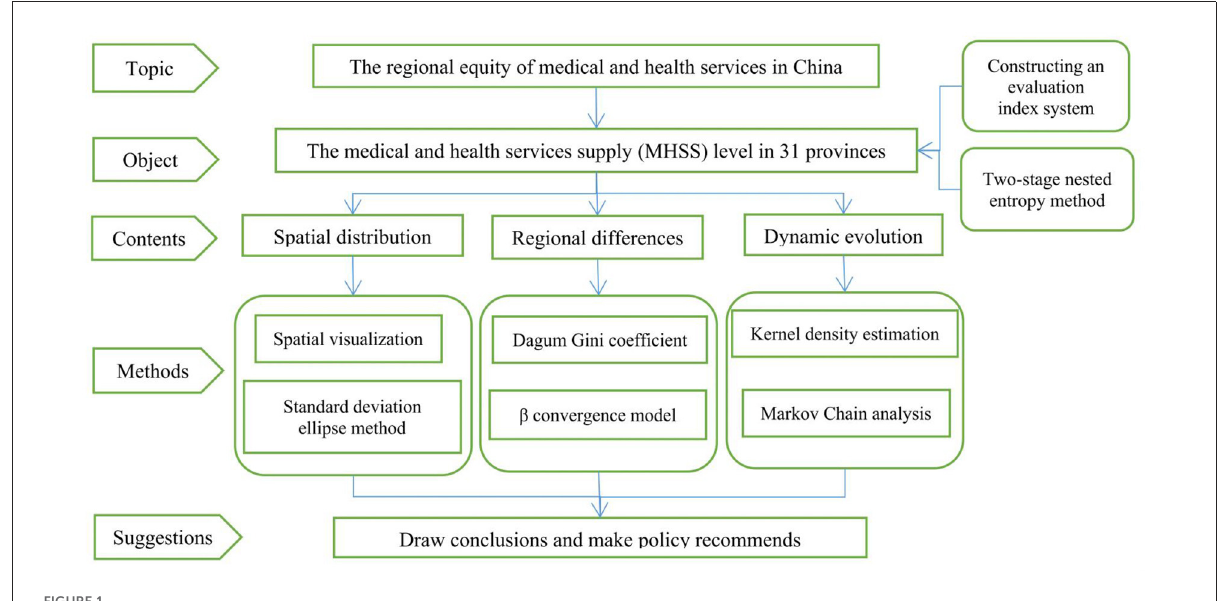
FIGURE1 The research framework of this